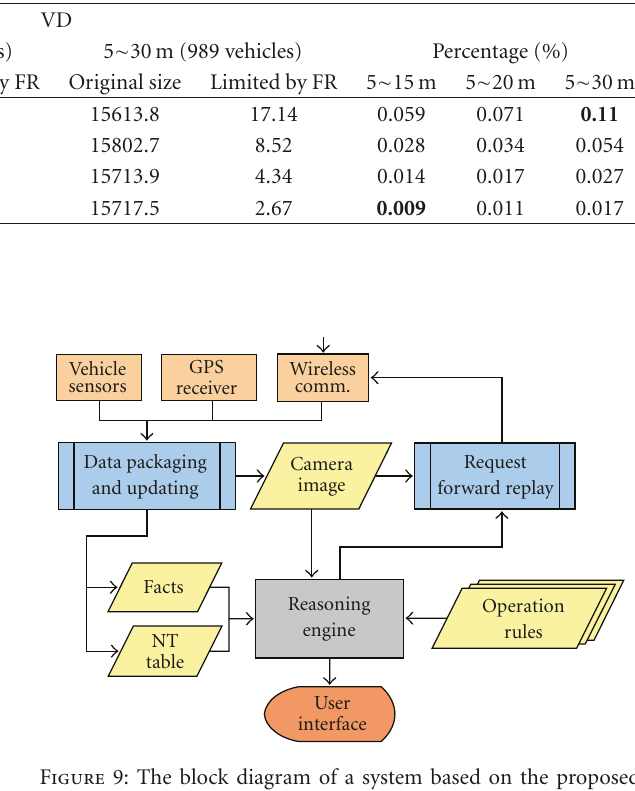
Table 3: The results of network transmission simulation (VD: vehicle distance, FR: forward distance, unit: MB).